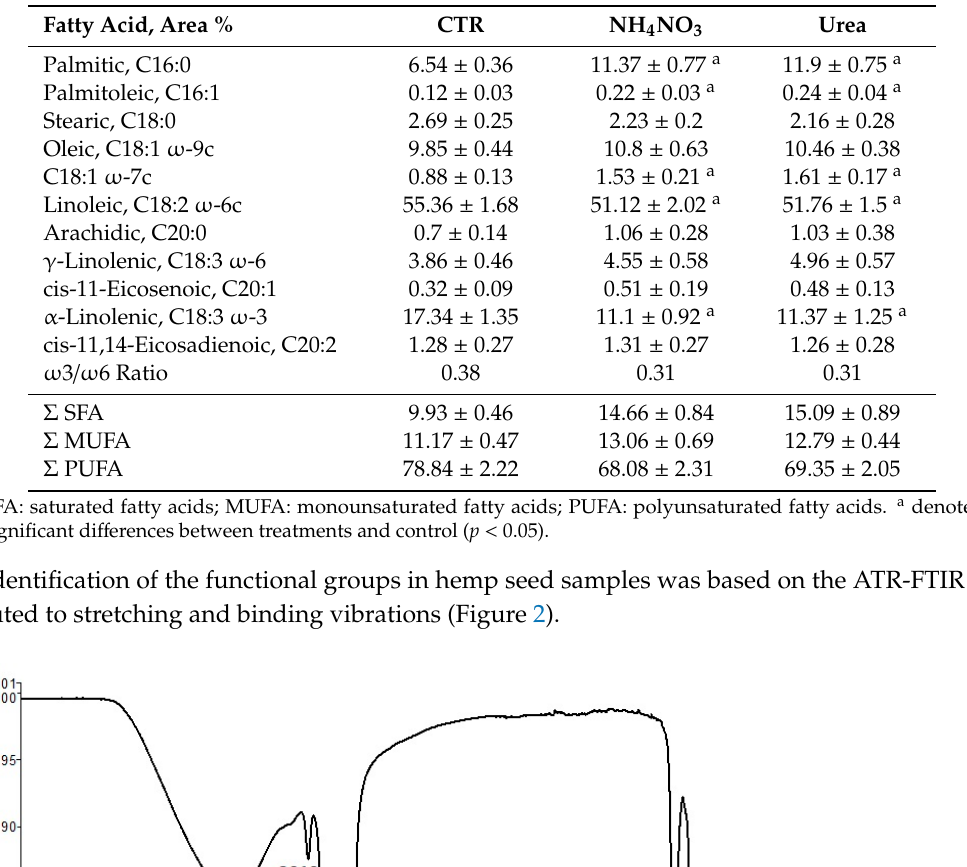
Table 2. Fatty acid profile of seeds from hemp plants fertilized by ammonium nitrate (NH 4 NO 3 ) and urea. CTR, control seeds. Data are means ( n = 4) ± SE.